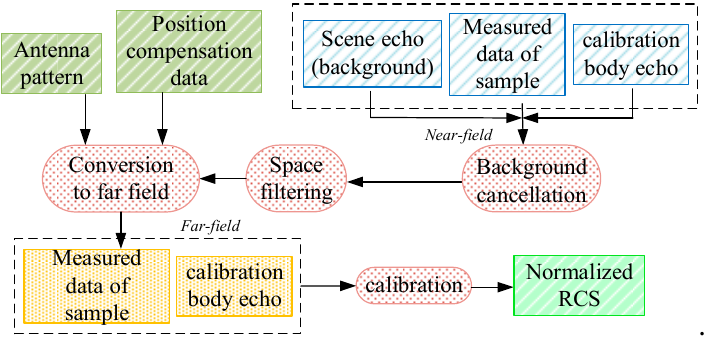
Figure 5. The flow diagram of measured data processing procedures.